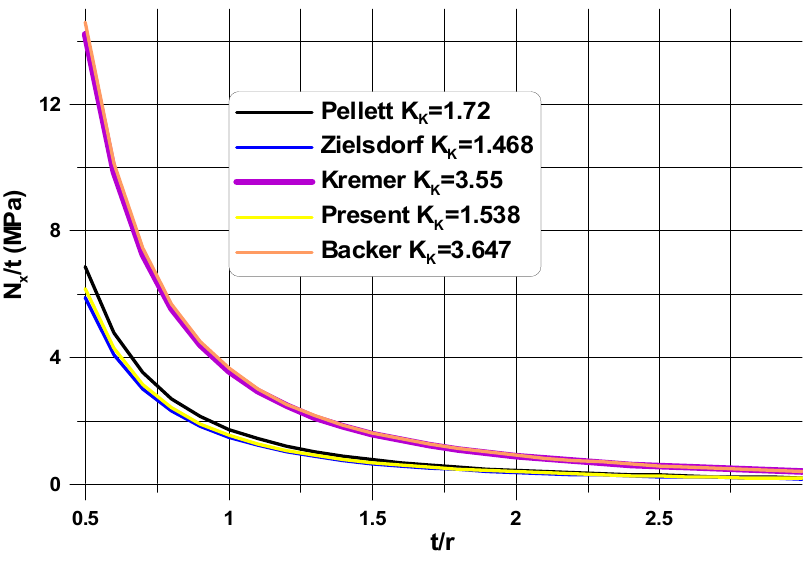
Figure 3. Comparison of the analytical buckling load predictions.